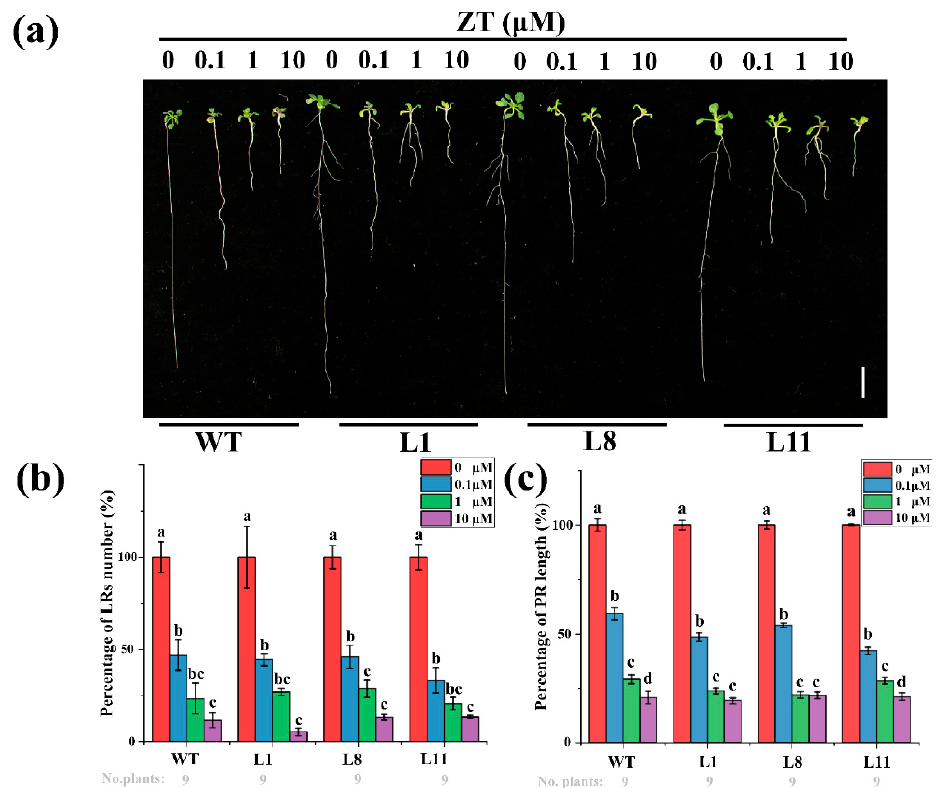
Figure 5. MdCKX5.2 -overexpressing Arabidopsis treatment with exogenous ZT. ( a ) Morphological characteristics of transgenic lines (L1, L8, and L11) and wild-type lines (WT) under different concentrations (0/0.1/1/10 µM) exogenous ZT. ( b , c ) Percentage of primary root (PR) and lateral roots (LRs) number in the MdCKX5.2 -overexpressing and WT plants in MS medium containing different concentrations of ZT. Vertical coordinates represent a percentage of the time at 0 µM for each treatment. The gray numbers under bar charts indicate the number of plants measured (No. of plants). Error bars, ±SD. The letters (a, b, c, and d) indicate statistically significant differences ( p < 0.05) between different groups by analysis of variance (ANOVA). Bars = 1 cm.